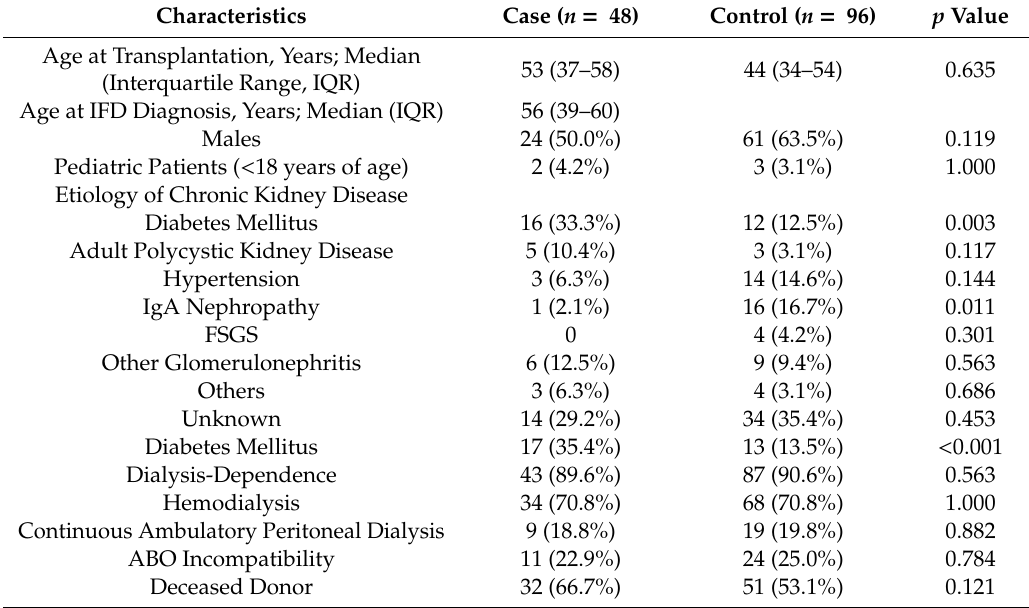
Table 1. Clinical characteristics of kidney transplant recipients with invasive fungal